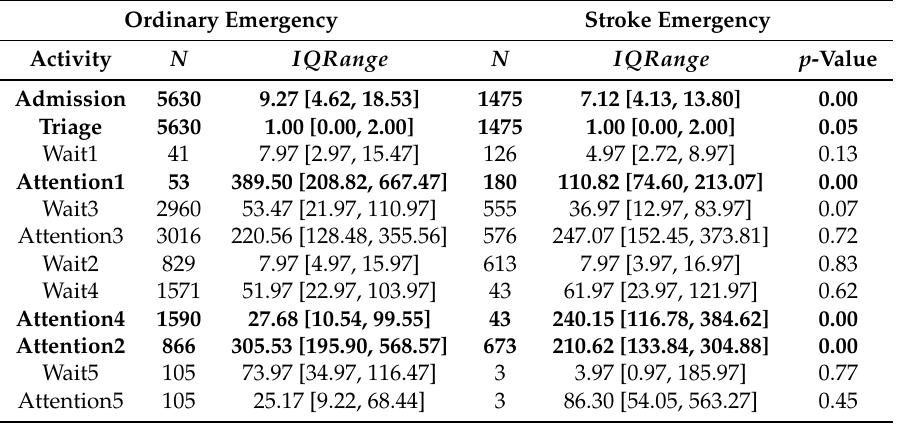
Table 1. Sample size and descriptive statistics for the time (in minutes) for Ordinary and Stroke Unit Admission Nodes. Bold rows are for statistically significant differences between